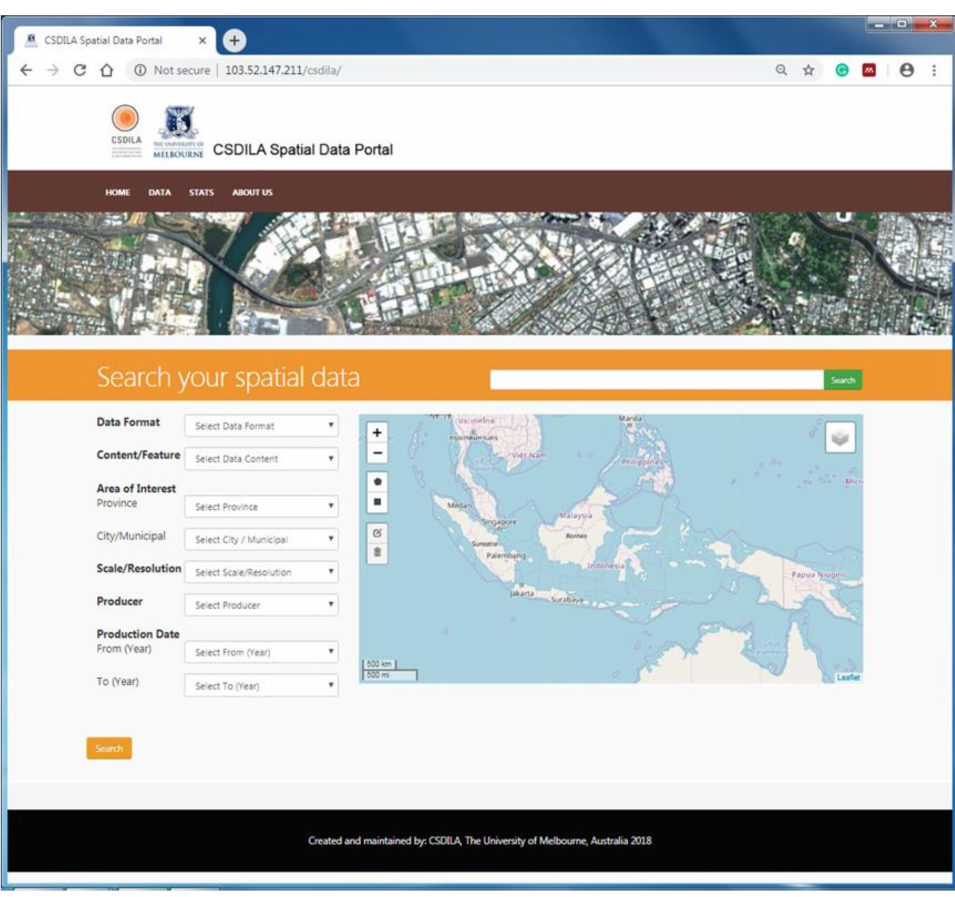
Figure 4. Search page (home